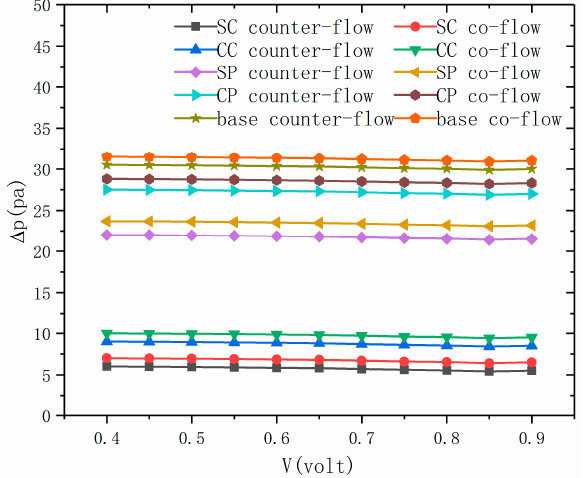
Figure 7. Comparison of pressure drop under the four tubular structures and base model.